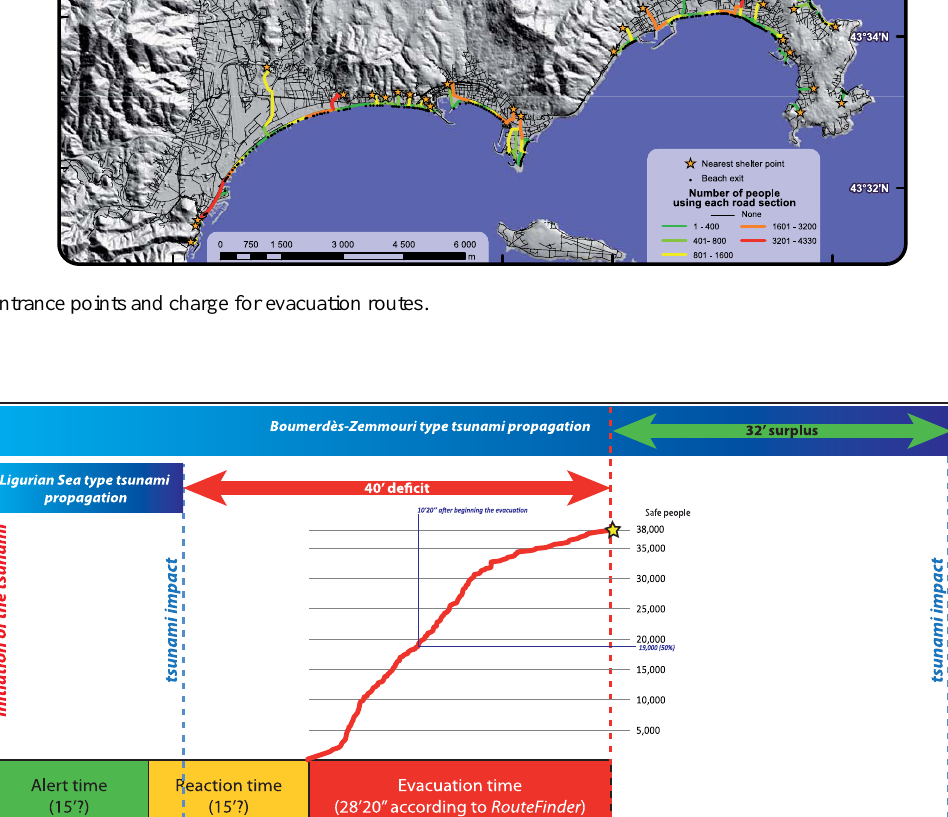
Nat. Hazards Earth Syst. Sci., 13, 1735–1743, 2013